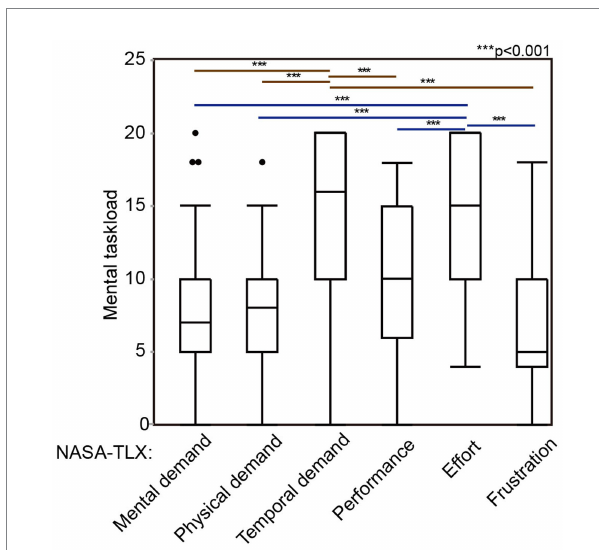
FIGURE 1 The subscales of mental task load evaluated with NASA-TLX. Forty- seven otolaryngologists performed ESS for 3D-printed sinus models and evaluated their mental workload during ESS, in a point of mental demand, physical demand, performance, effort, and frustration. ESS, endoscopic sinus surgeries; NASA-TLX, national aeronautics and space administration-task load index. *** p <